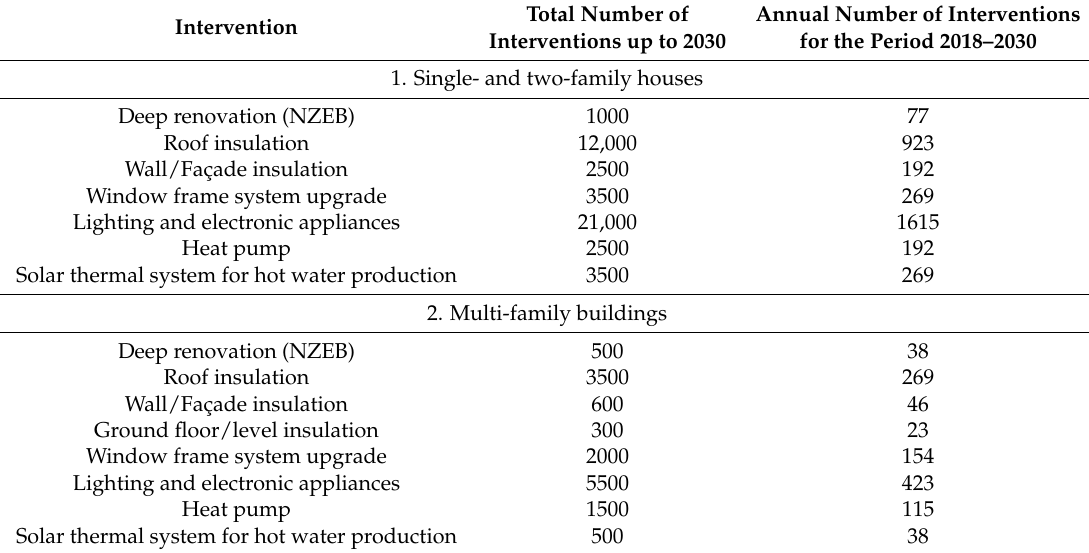
Table 8. Proposed number of energy efficiency interventions in existing residential buildings of Cyprus up to 2030.